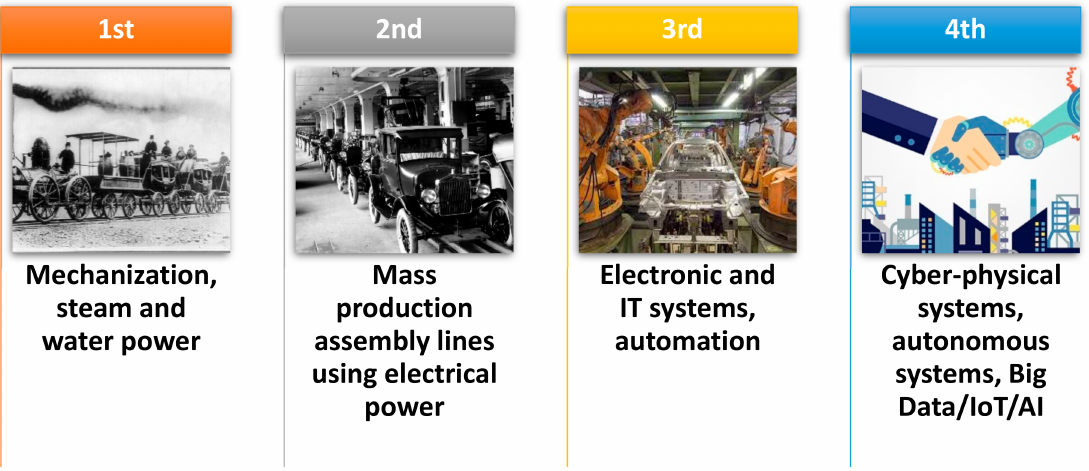
Figure 1. The four industrial